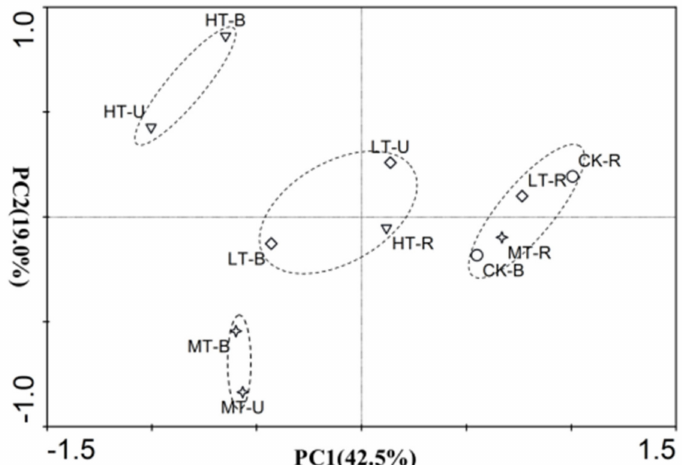
Figure 6. Principal component analysis based carbon source utilization patterns of microbial communities. PC1, the first principal component; PC2, the second principal component; CK, 0 mg/kg; LT, 500 mg/kg; MT, 1000 mg/kg; HT, 1500 mg/kg; R, rhizospheric soil; B, bulk soil; U, unplanted soil. The data matrix included 11 samples (each was the mean of 3 repetitions) and 31 variables.